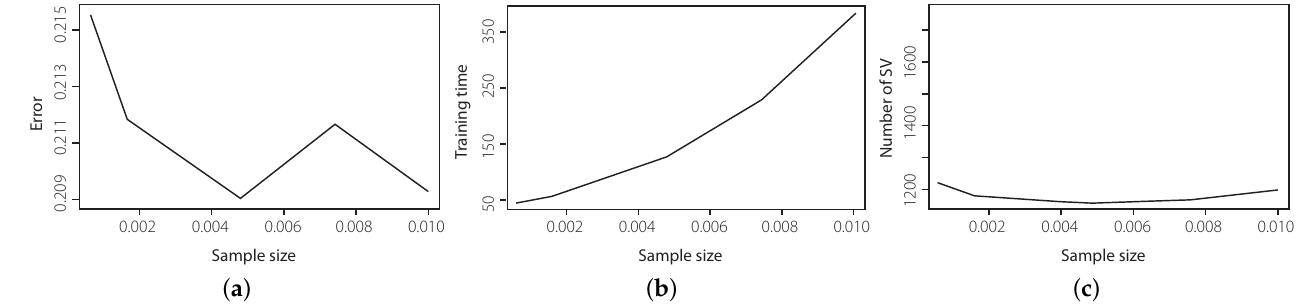
Figure 4. Plots of the effect of parameter η 2 (size of the first small SVM problem in Algorithm 2 in order to obtain projection directions) over: error ( a ), time ( b ), and number of SV ( c ) for data set covtype.binary. Larger sample sizes were not considered because of the increase in training